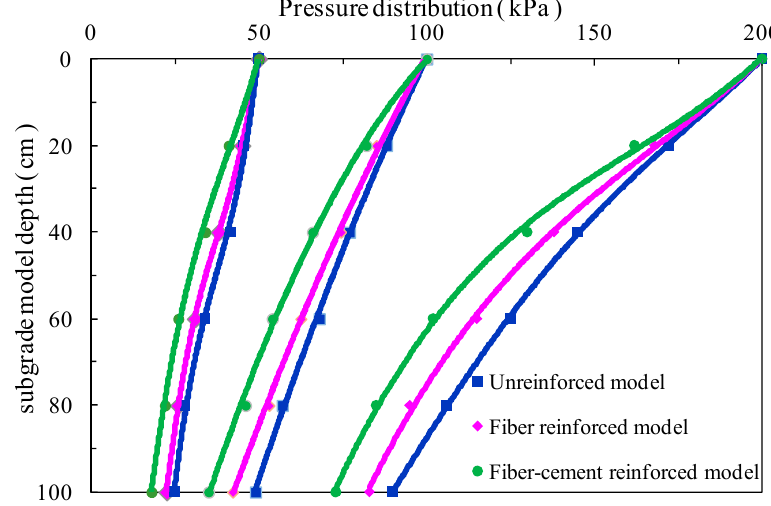
Figure 4. Relationship curves between pressure distribution and subgrade model depth.